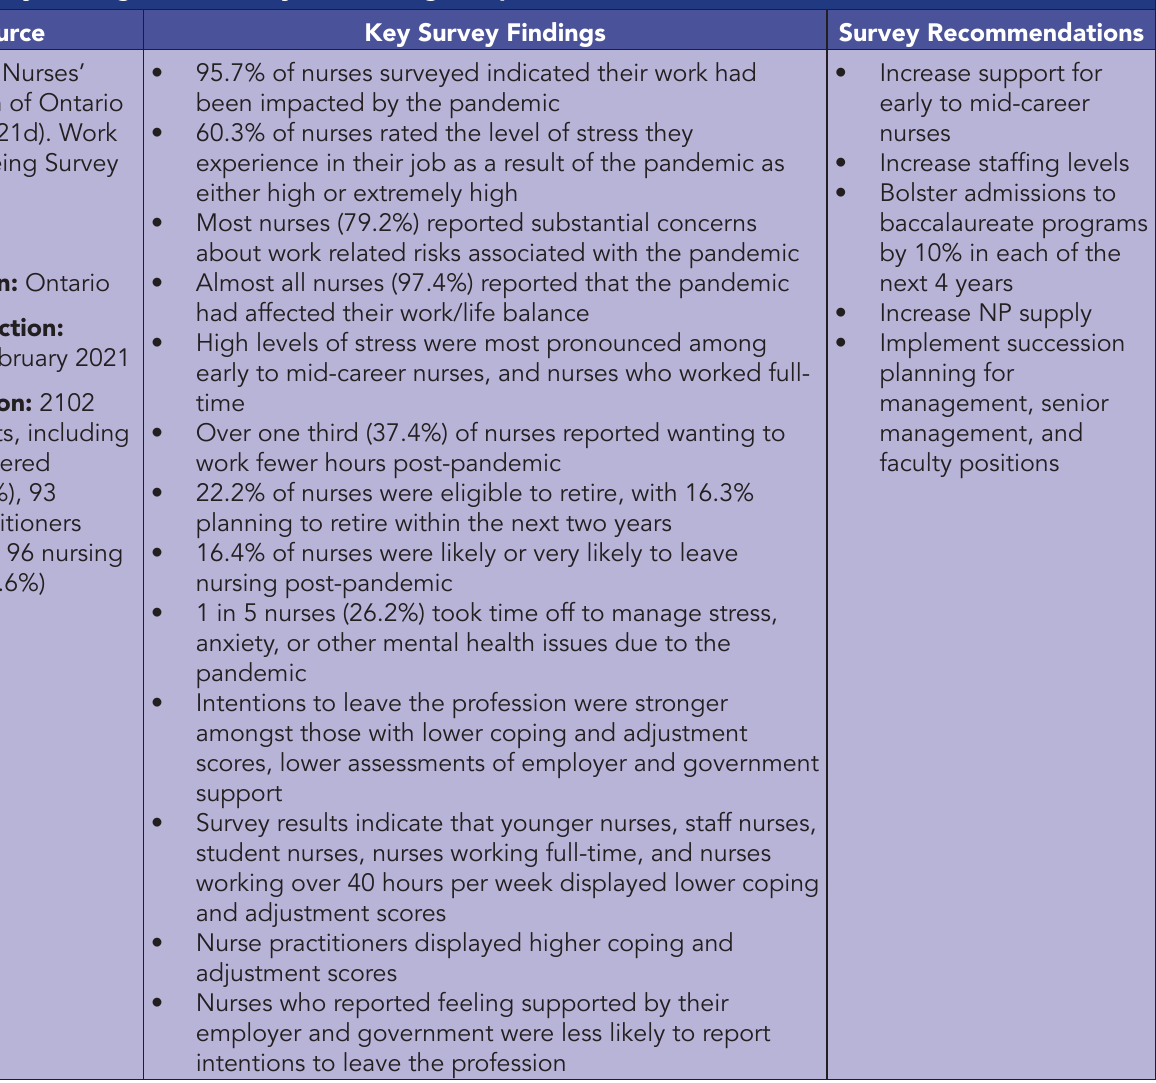
Table 11: Key findings from surveys of nursing perspectives included in Jurisdictional Scan Key Findings from Surveys of Nursing Perspectives Included in Jurisdictional Scan